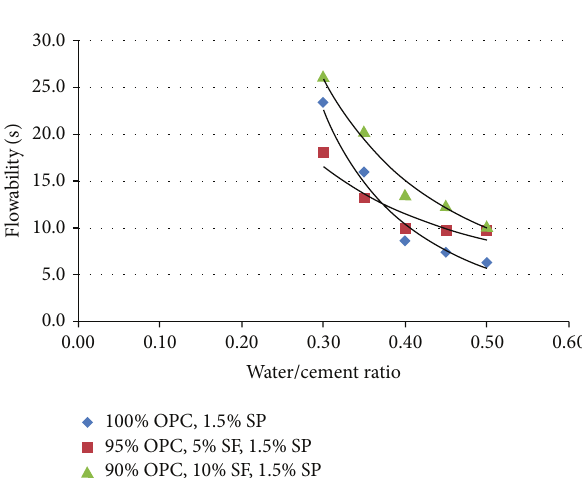
Figure 1: Influence of water/cement ratio on the workability for 100% OPC; 95% OPC, 5% SF; and 90% OPC, 10% SF.